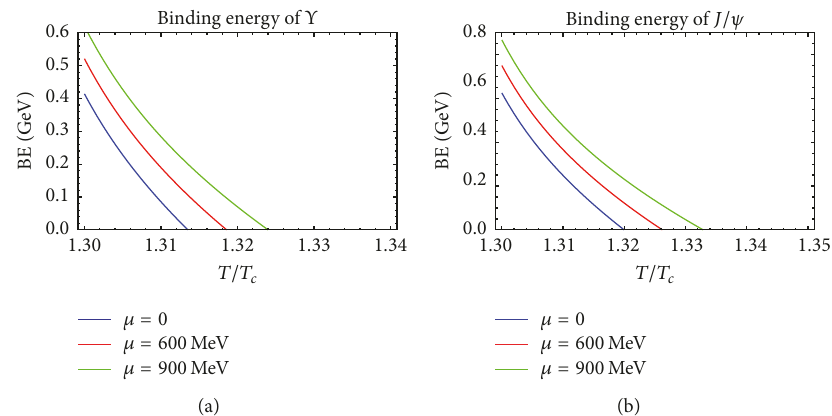
Figure4:Dependenceof Υ bindingenergy(inGeV)ontemperature 𝑇/𝑇 𝑐 (a)anddependenceof 𝐽/𝜓 bindingenergy(inGeV)ontemperature 𝑇/𝑇 𝑐 (b) at different values of chemical potential.